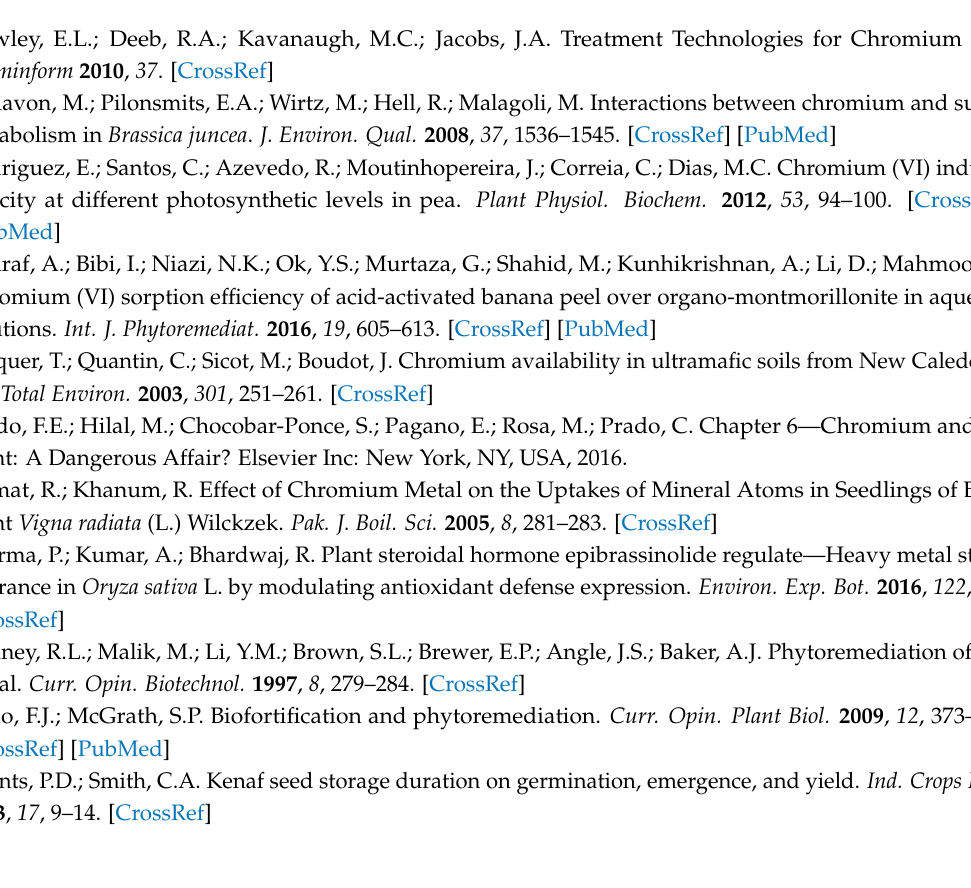
s1, Figure S1: Effects of chromium treatments on growth of two kenaf cultivars (Zhe70-3 and Zhe77-1) in the hydroponic experiment, chromium (Cr 3+ ) concentrations were 0, 0.5, 1.0 and 1.5 mM. (a) cultivar Zhe70-3; (b) cultivar Zhe77-1. Table S1: Effects of chromium stress (1.6 mM) on the shoot height and root length of nine kenaf cultivars. Table S2: Effects of chromium stress (1.6 mM) on the dry weight of nine kenaf cultivars. Table S3: Effects of chromium stress on Cr content, BCF and TF in shoot and root of kenaf seedlings. Extremely small amounts of Cr content under control condition in these kenaf materials can be